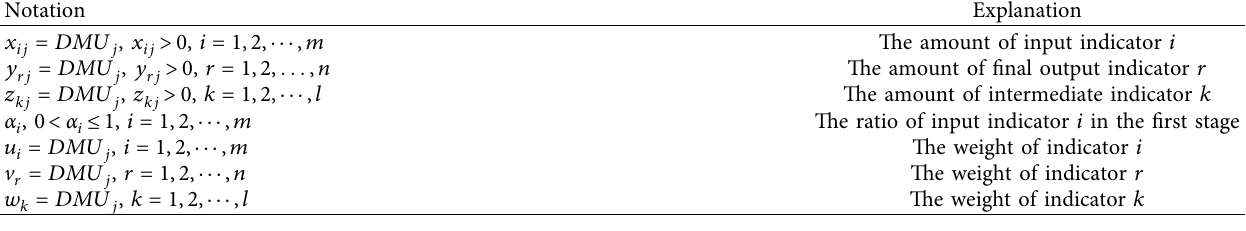
Table 1: The notations.